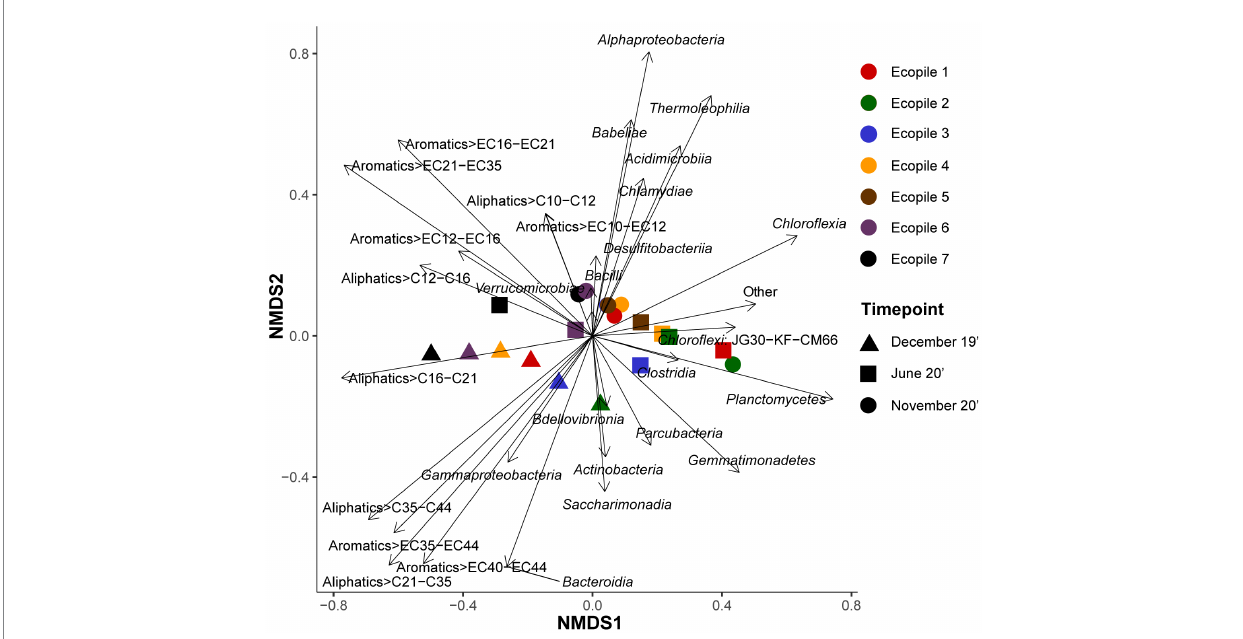
FIGURE 5 Non-metric multidimensional scaling (NMDS) analysis using Bray-Curtis distance matrix. NMDS plot where the shapes represent the samples according to sampling times and colors according to the Ecopile. Bacterial classes and contaminants were used as explanatory variables driving the Ecopiles distribution pattern.